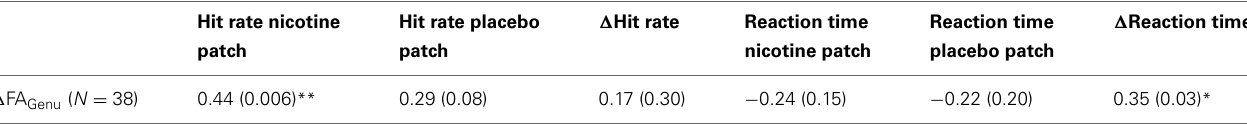
Table 4 | Correlation coefficients for intersession difference in FA values for the genu and corpus callosum and measurements of sustained attention and reaction